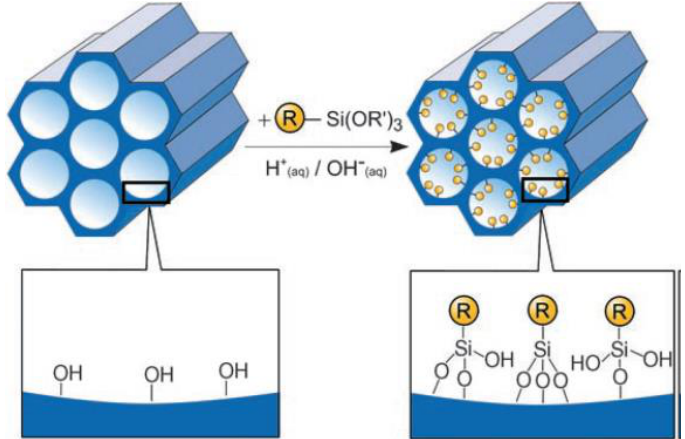
Figure 5. Grafting of a generic silyl-derivative RSi(OR’) 3 onto a mesoporous silica pore walls [22]. Reprinted with permission from [22]. Copyright 2006, John Wiley and Sons.